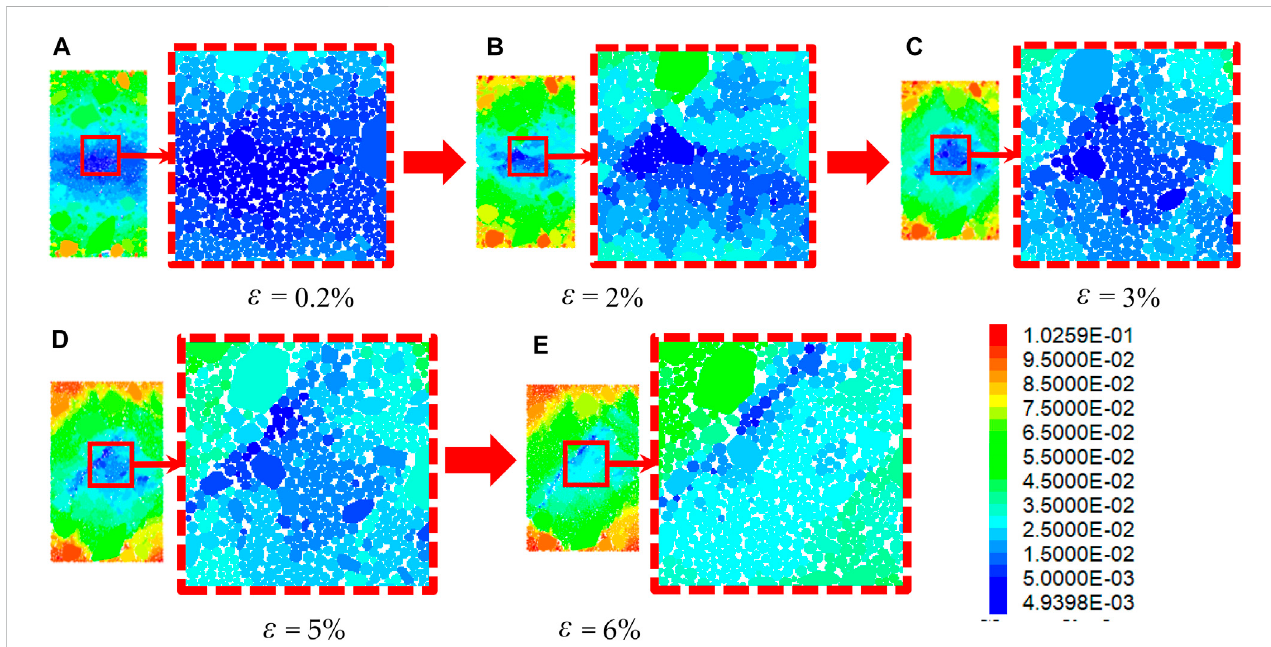
FIGURE 11 Theevolutionofparticledisplacementintheshearprocessingzonefortheslagcontentof40%at fi vestages: (A) ε =0.2%, (B) ε =2%, (C) ε =3%, (D) ε =5%, and (E) ε =